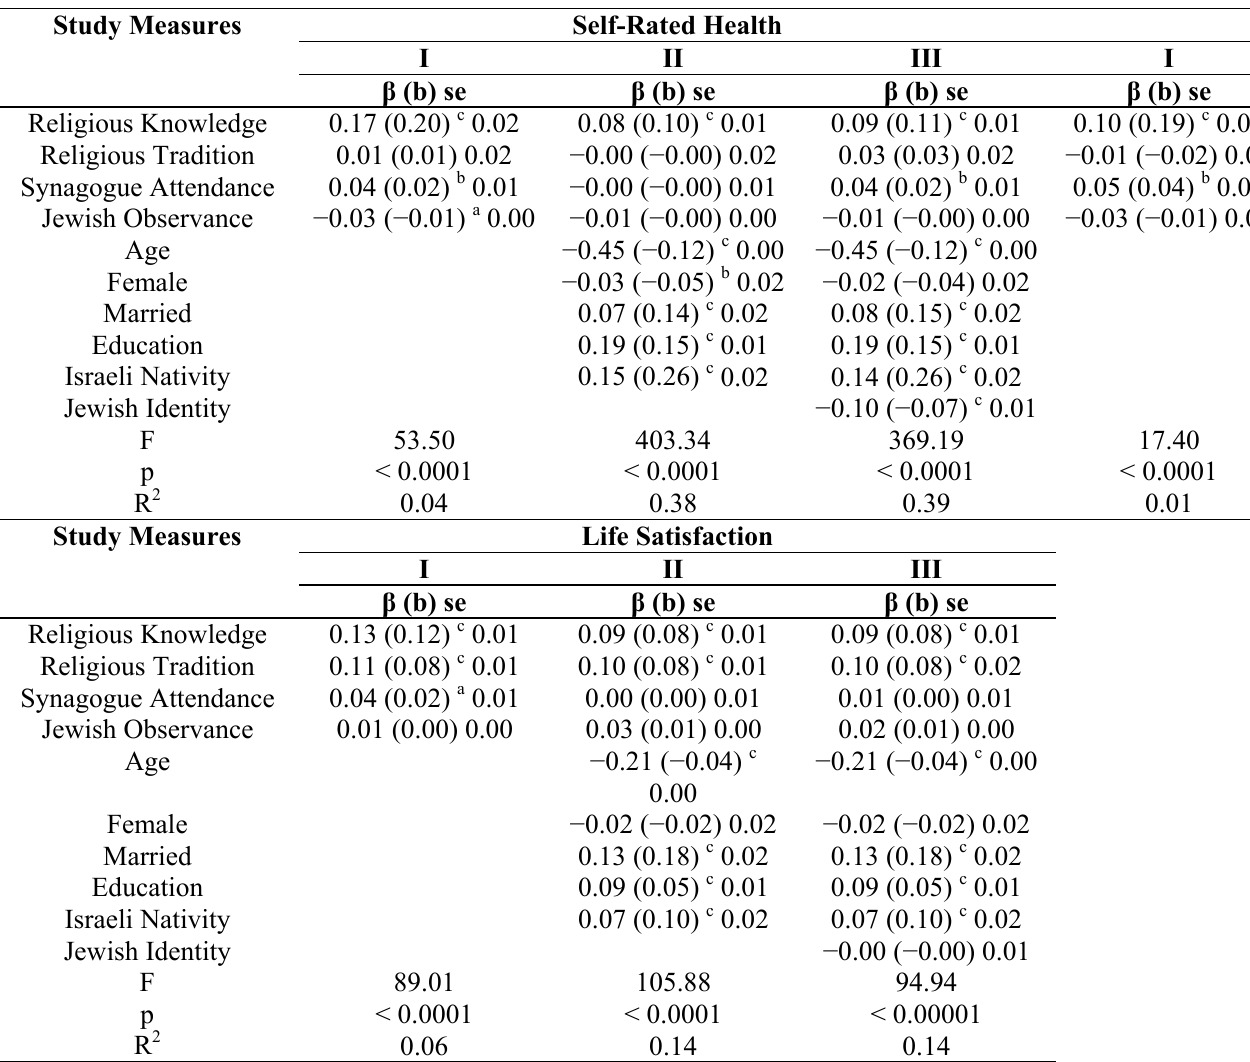
Table 3. Regressions of well-being outcomes on Jewish religious